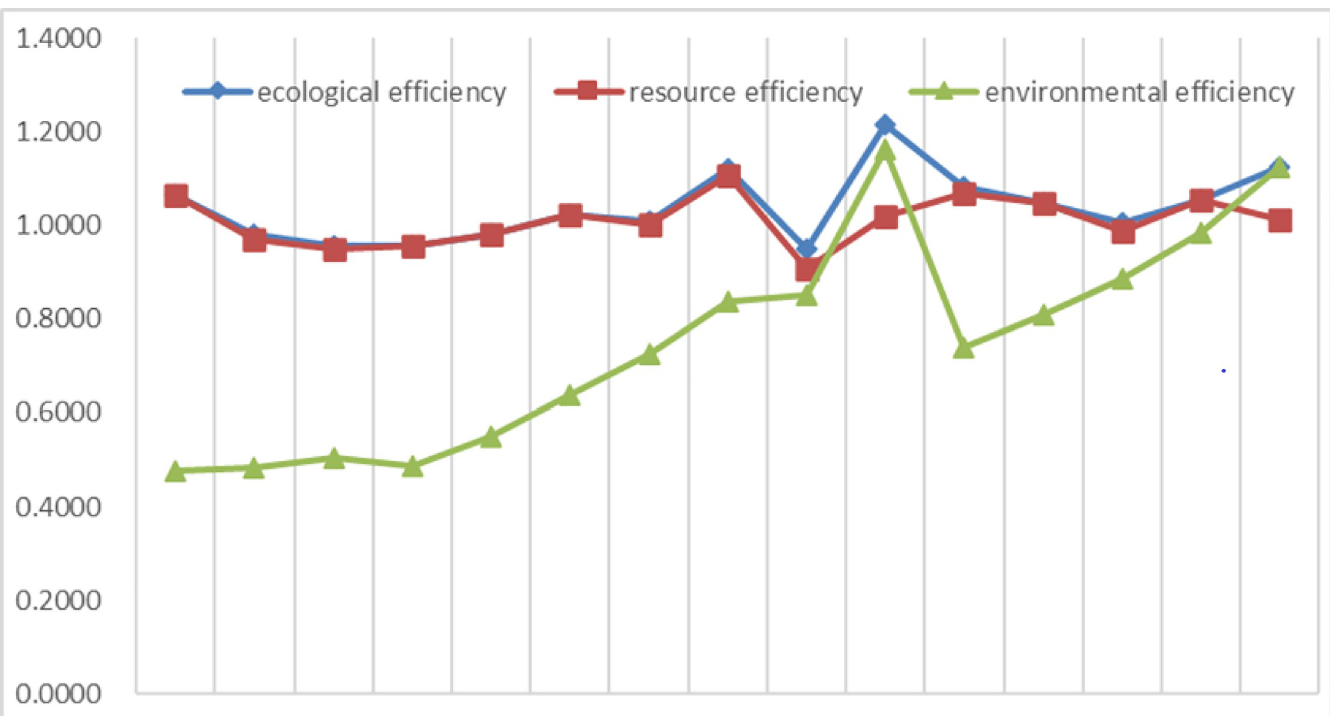
Fig 2. Ecological Efficiency of Xinjiang between 2001 and